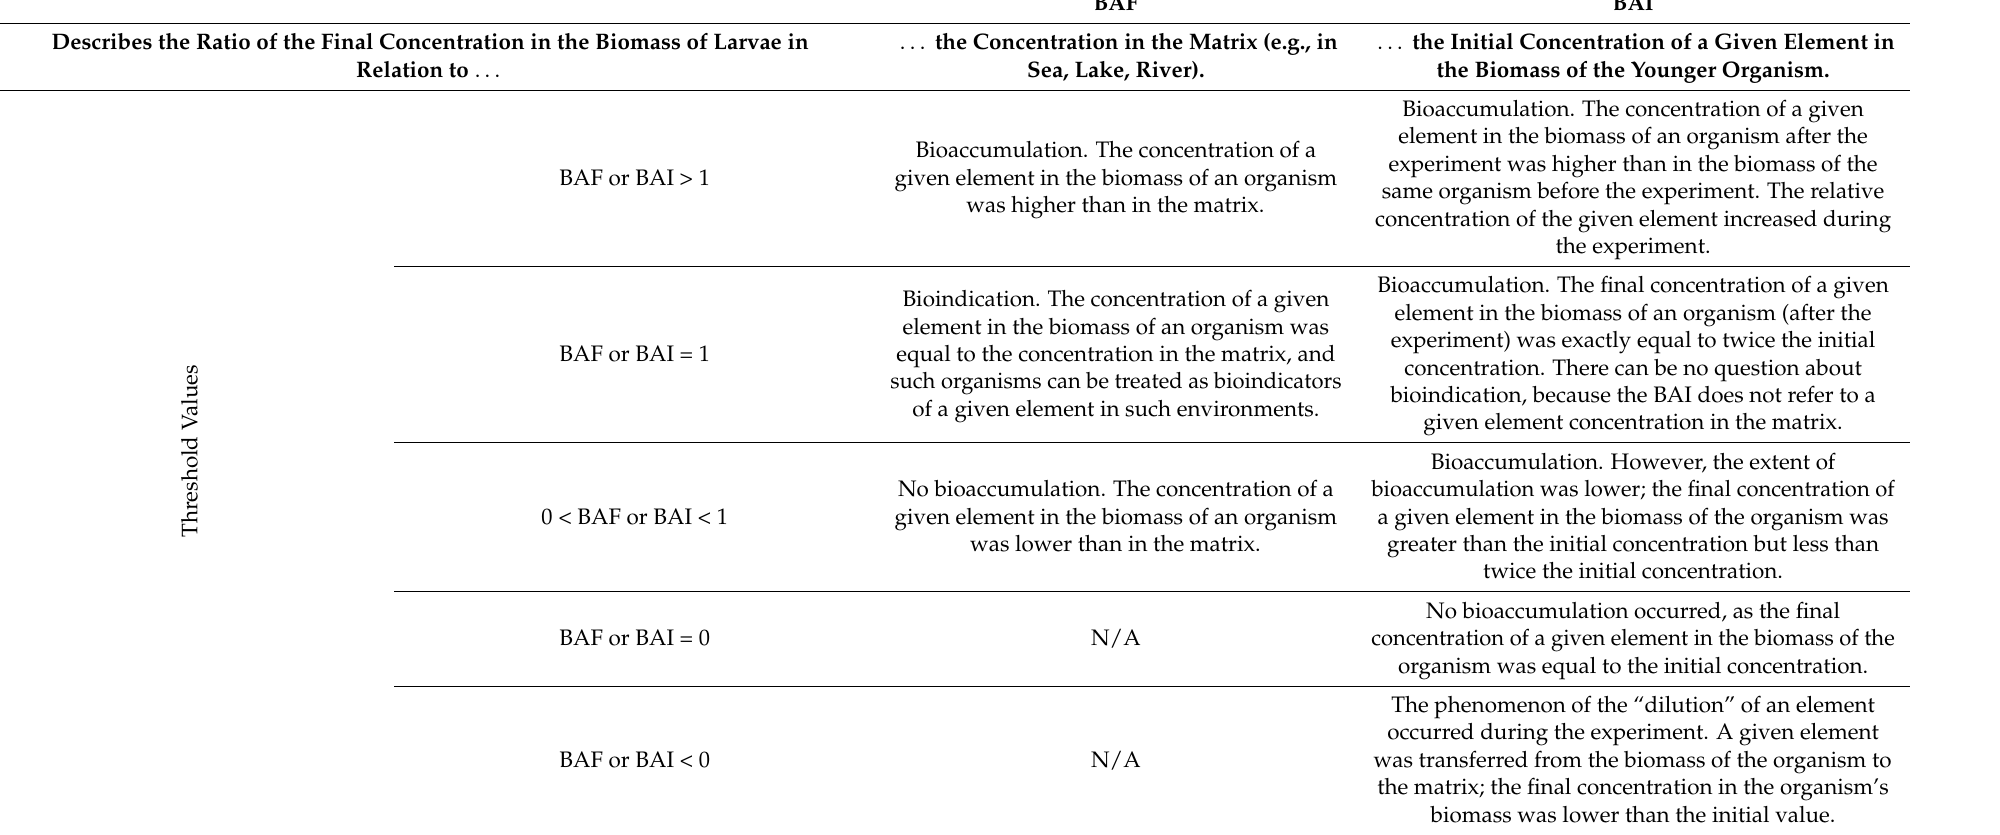
Describes the Ratio of the Final Concentration in the Biomass of Larvae